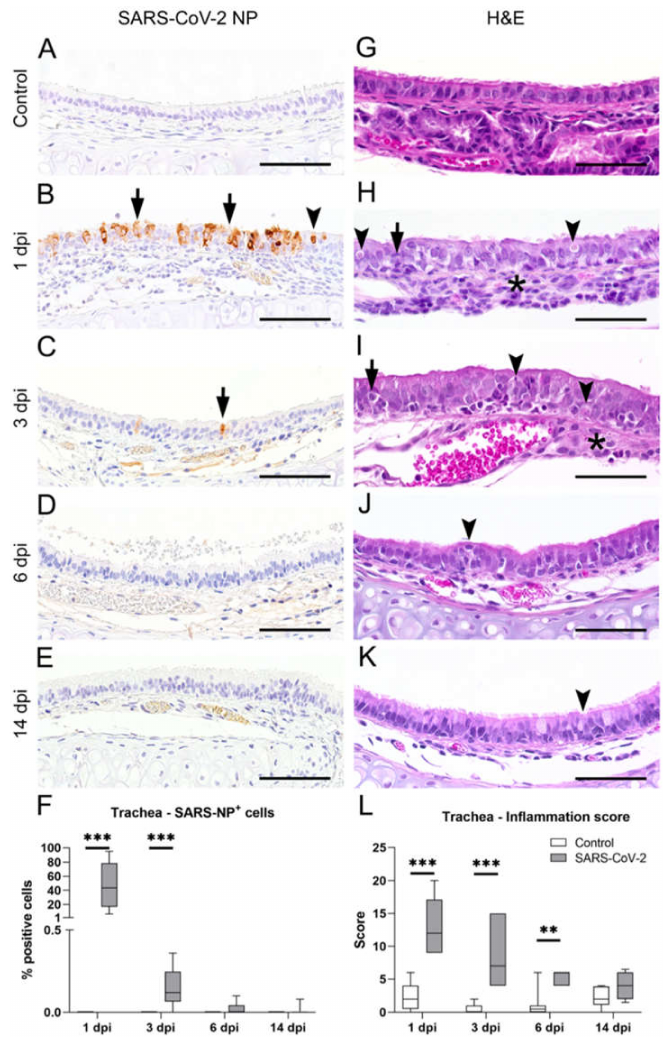
Figure 1. Characterization of inflammatory alterations and virus load in the trachea of severe acute respiratory syndrome coronavirus 2 (SARS-CoV-2)-infected hamsters. Representative images of